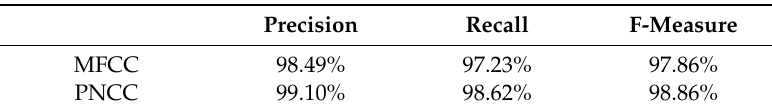
Table 4. Precision-Recall analysis.